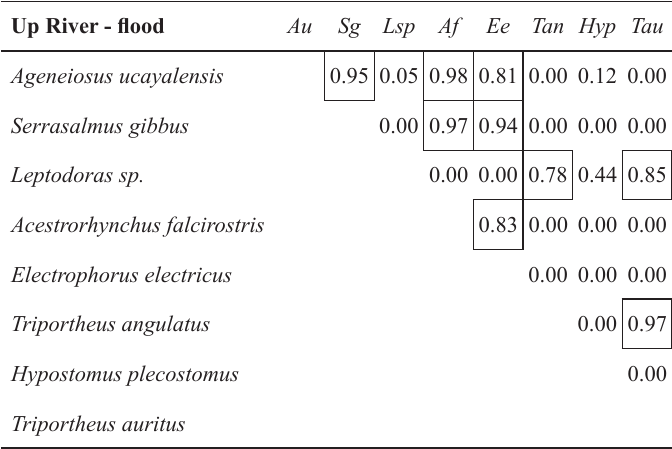
Niche overlap between pairs of species analyzed from Upriver area of Coaracy Nunes Dam, Ferreira Gomes – Amapá